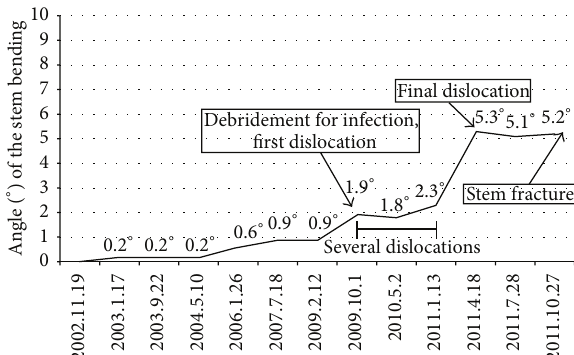
Figure 5: The stem bending was 0 ∘ immediately after the revisional THA. The stem bending gradually progressed during first five years. The stem bending immediately after the first dislocation was 1.9 ∘ and then the stem bending at final dislocation was 5.3 ∘ . The stem bending before the stem fracture was 5.2 ∘ .